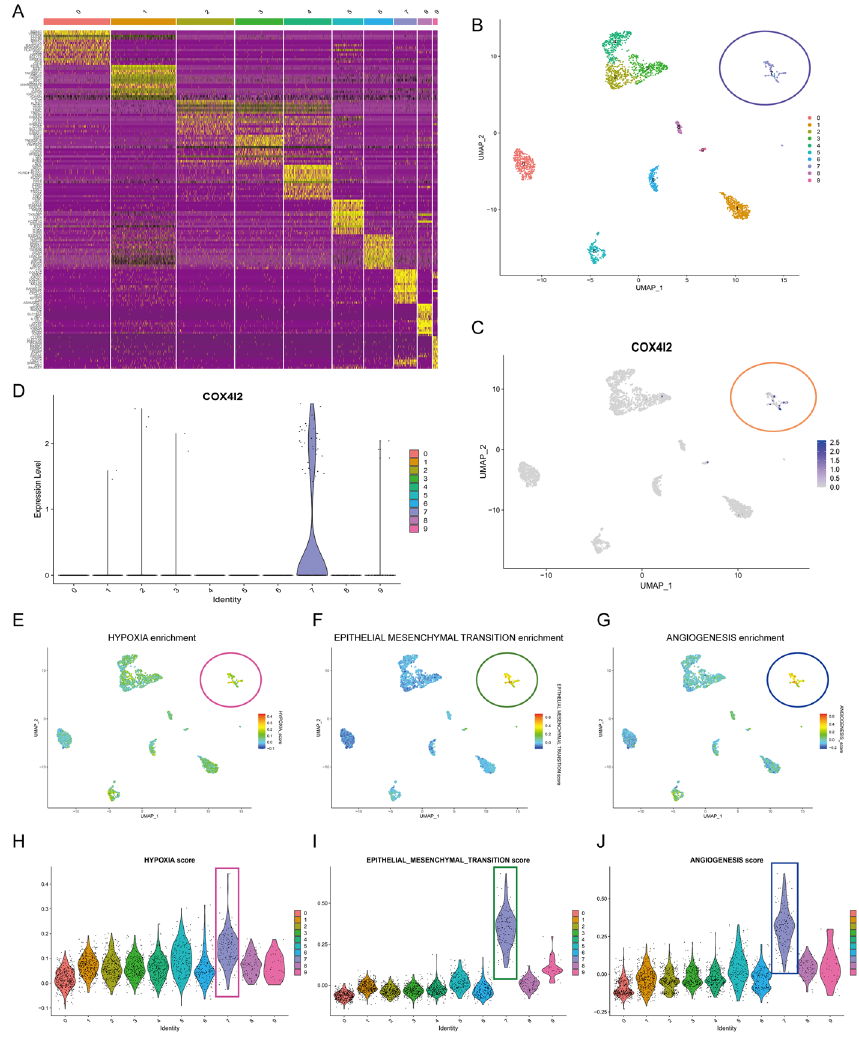
Fig. 4 Single‑cell analysis of COX4I2 based on single‑cell RNA sequencing dataset CRC‑016‑01‑1A. a Cellular components. b UMAP plots showing different CRC cell types after quality control, reduction of dimensionality, and clustering. c UMAP plots showing expression of COX4I2 clusters. d Violin plots of CRC cell cluster markers and COX4I2 in various cell types. Expression was measured as log 2 (TP10K Functional enrichment analysis. h – j Enrichment scores of genes from the Hallmark hypoxia gene set for each cell, from the gene set variation analysis: h HALLMARK_HYPOXIA, i EPITHELIAL_MESENCHYMAL_TRANSITION, j ANGIOGENESIS. For Abbreviations, see Abbreviation